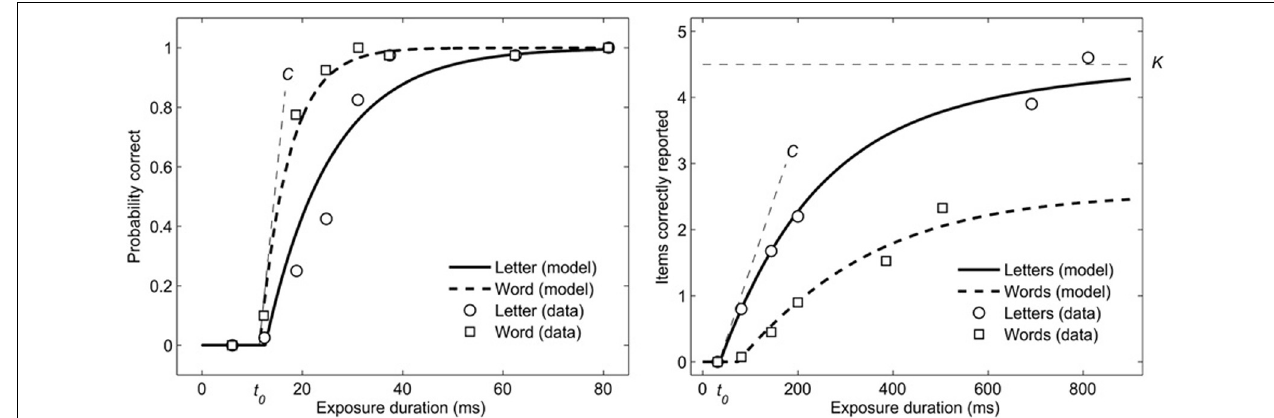
FIGURE 1 | Illustration of observed data and model fit for letter and word processing in a single subject in Experiments 2 (left) and